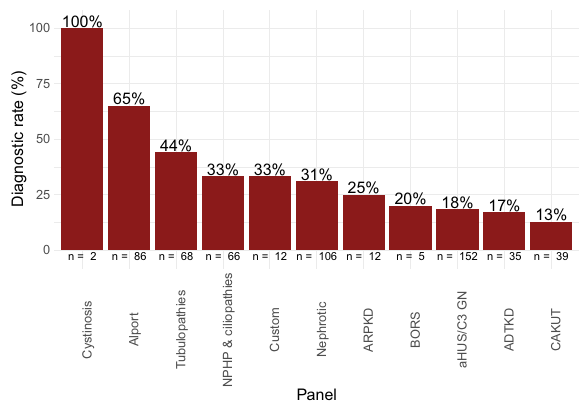
Fig. 4 Diagnostic rate of pathogenic or likely pathogenic variants, strati fi ed by panel. Variant classi fi cation was based on 2015 ACMG guidelines 20 . The number of families referred for each panel is shown along the x -axis. Abbreviated panels are as follows: ADTKD autosomal dominant tubulointerstitial kidney disease, aHUS/C3 GN atypical hemolytic uremic syndrome-C3 glomerulonephritis, Alport Alport syndrome, ARPKD autosomal recessive polycystic kidney disease, BORS branchio-oto renal syndrome, CAKUT congenital anomalies of the kidney and urinary tract, Nephrotic nephrotic syndrome, NPHP & ciliopathies nephronophthisis & related ciliopathies.